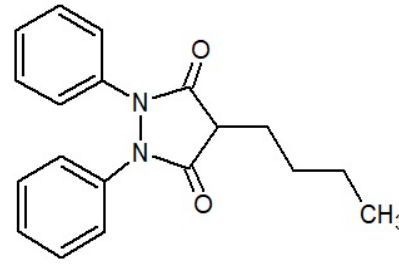
Figure 7. Scheme of phenylbutazone.